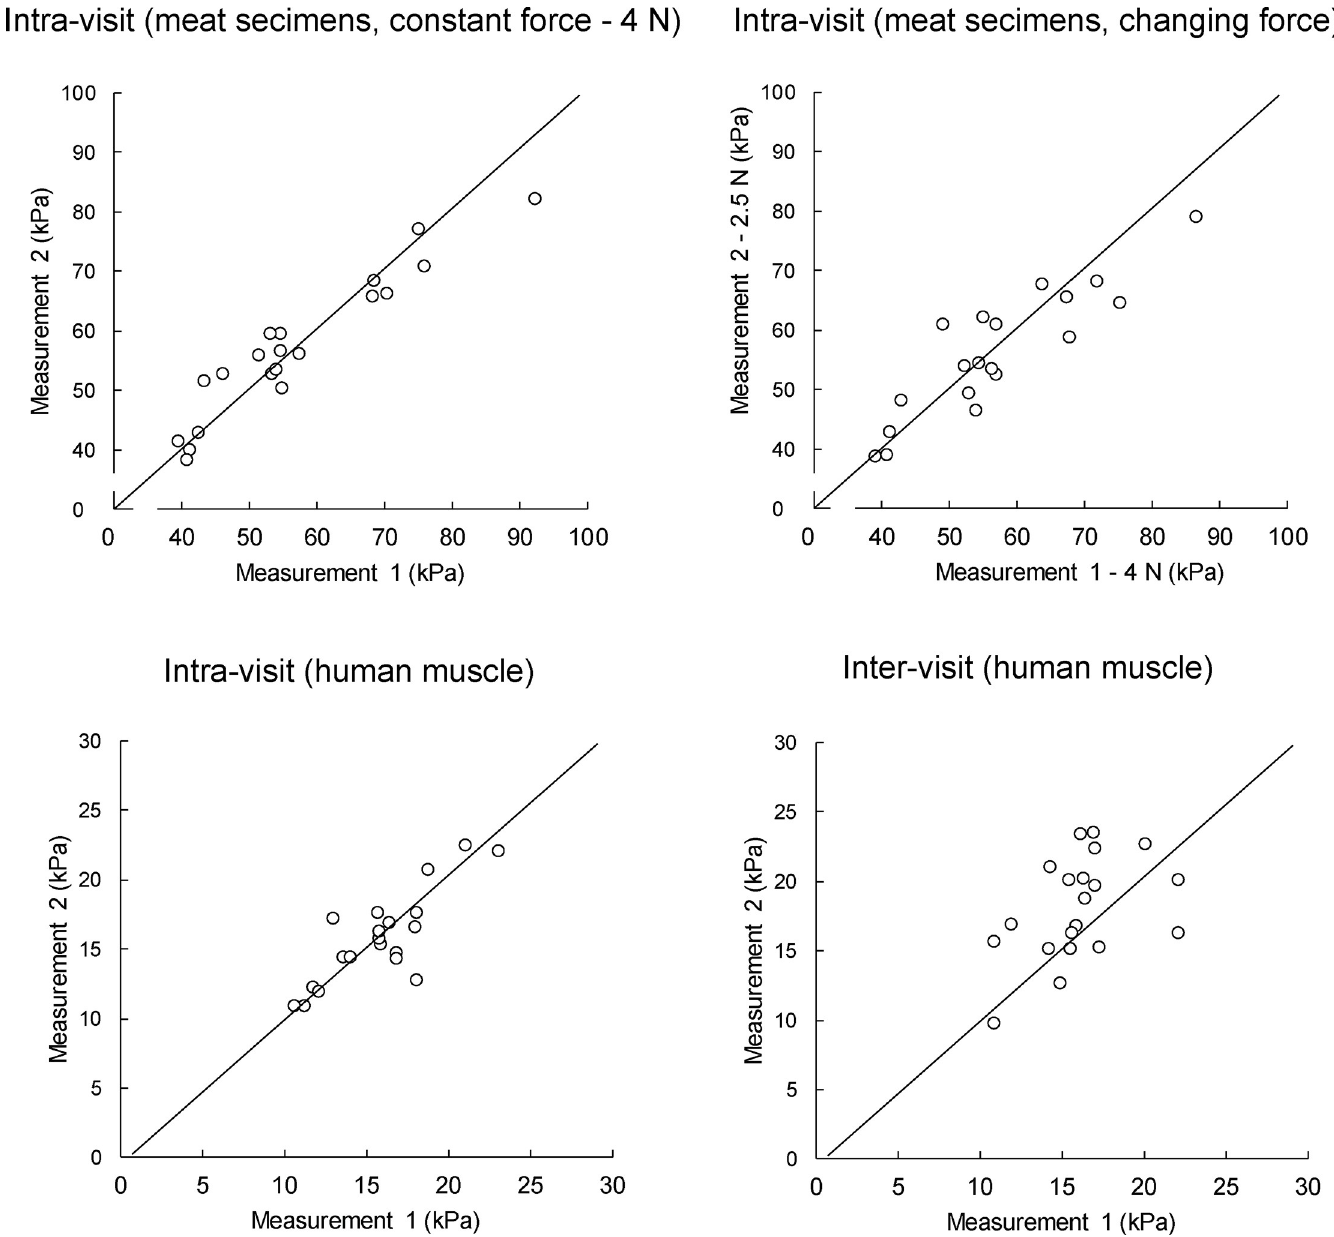
Fig 3. Scatter plots of measurements conducted with custom-made device. Diagonal line represents a perfect match between two measurements.